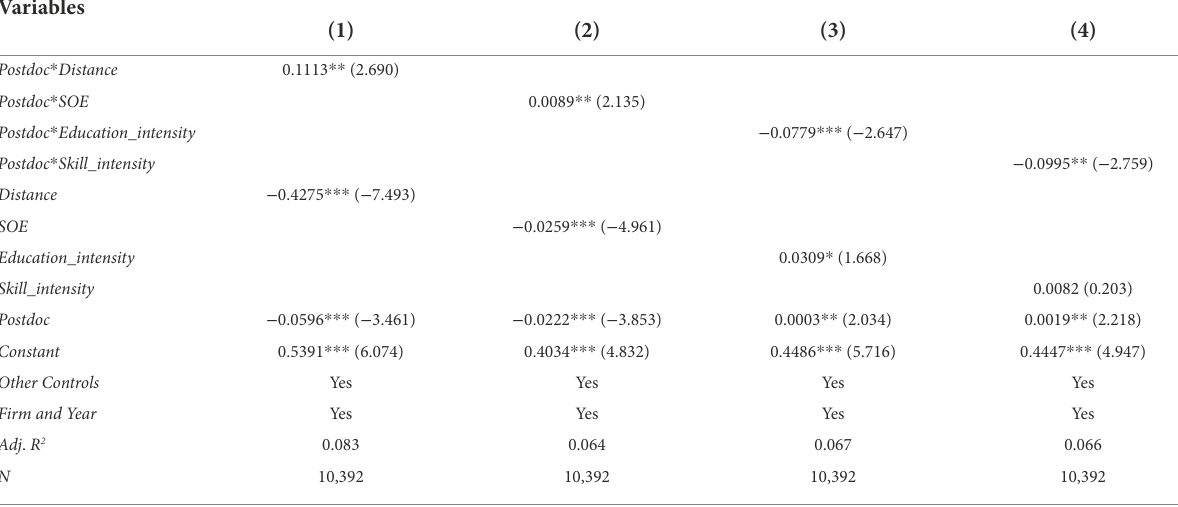
TABLE 9 The moderating role of university-industry collaboration